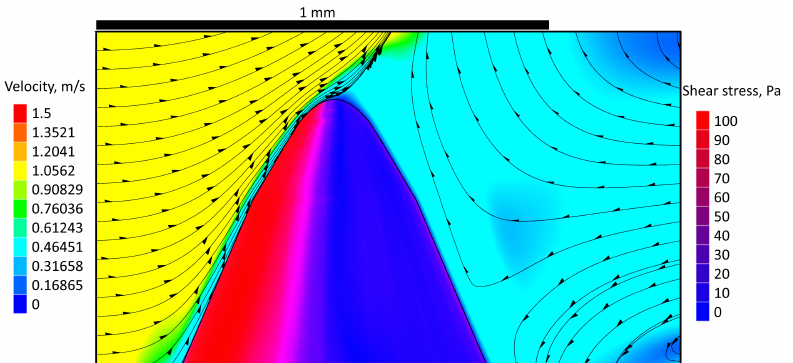
Figure 5. The velocity contour plot and streamlines for melt area and the shear stress contour plot for the dendrite tip area. The fluid flow has a 90-degree slope to the dendrite